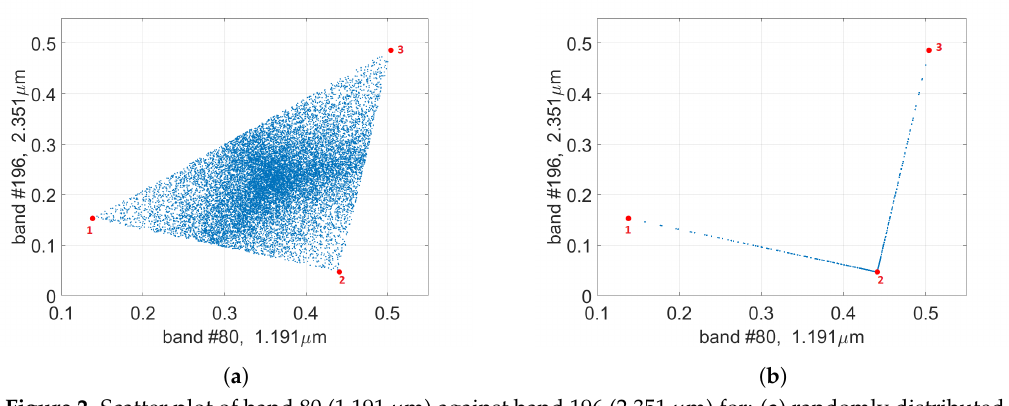
Figure 2. Scatter plot of band 80 (1.191 µ m) against band 196 (2.351 µ m) for: ( a ) randomly distributed data (Figure 1a) and ( b ) spatial structure (Figure